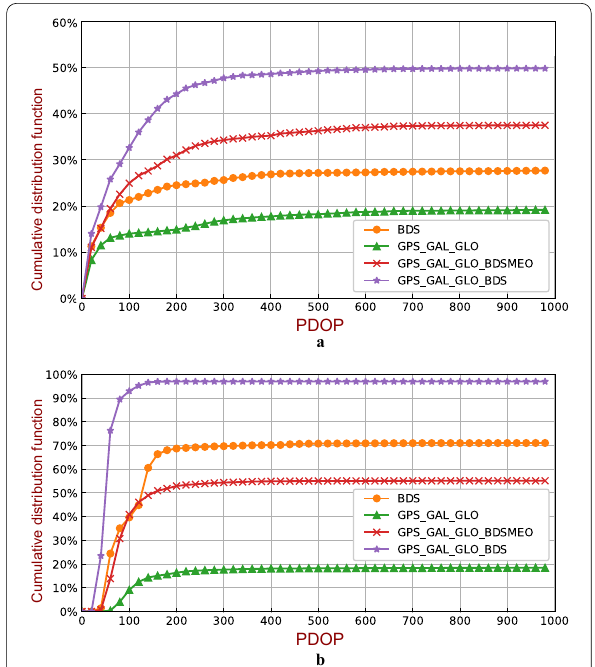
Fig. 11 Cumulative distribution function of different orbits PDOP values in different scenario: a SSTO; b GEO at 0°